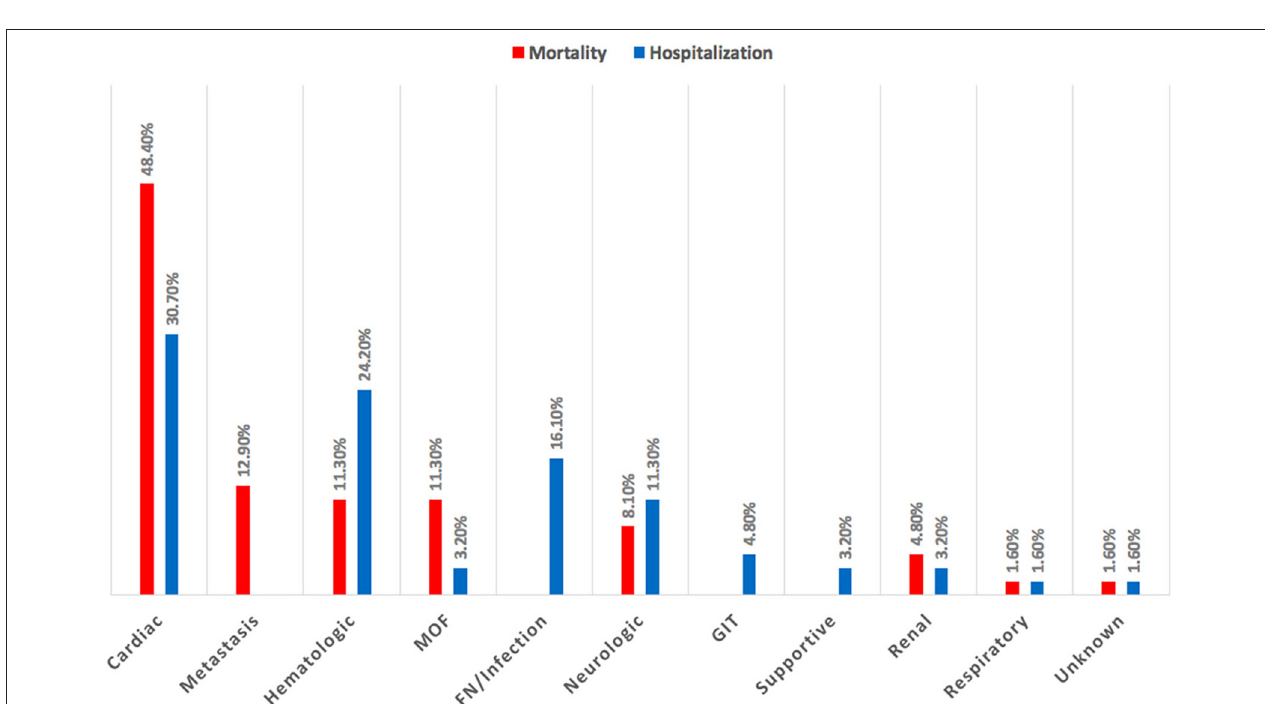
FIGURE 6 | Main medical cause for hospitalization and mortality among patients with cancer. Cardiovascular disease is the leading cause of hospitalization and mortality among patients with cancer. GIT, gastrointestinal tract; MOF, multi-organ failure.